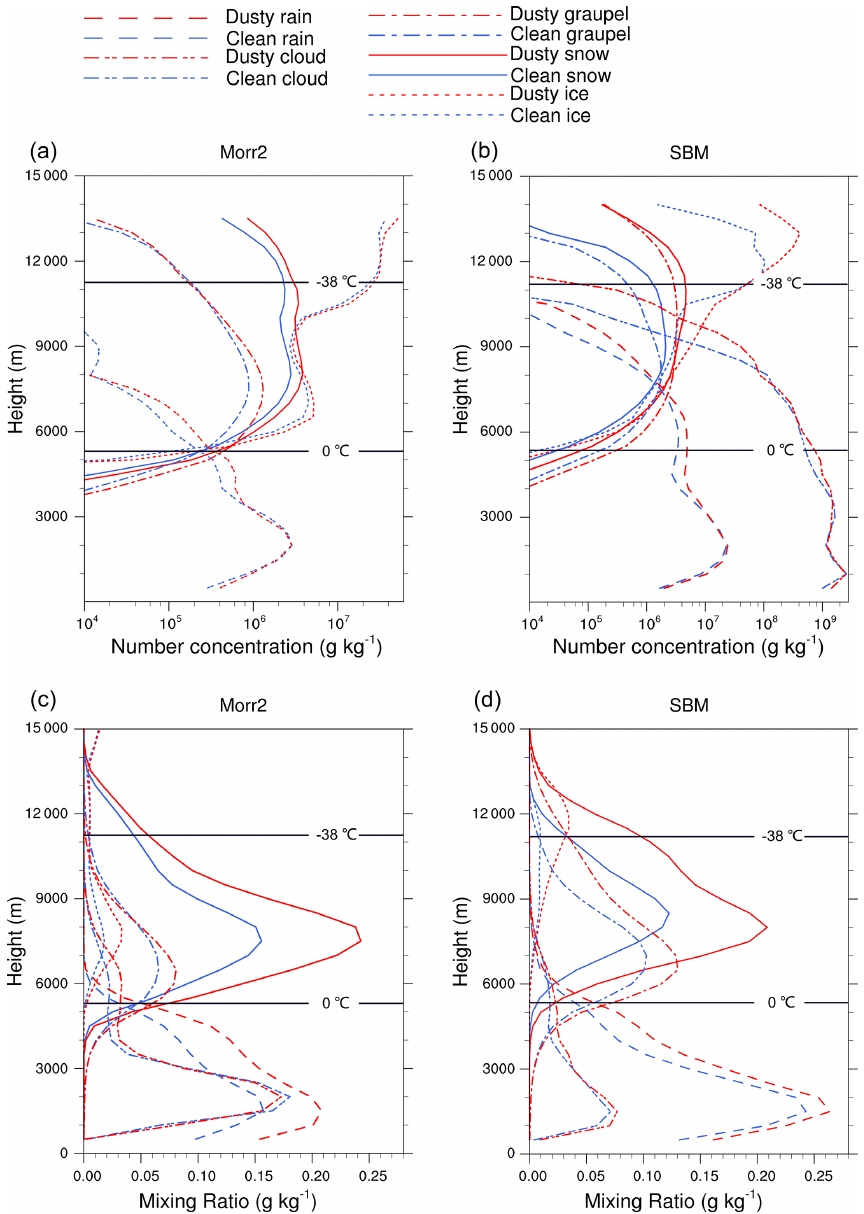
Figure 7. Vertical profiles of number concentrations of cloud hydrometers averaged among precipitation grids in the High-Pcp area from 11:00–15:00LT simulated by (a) Morr2-Clean (blue lines) and Dusty (red lines), and (b) SBM-Clean (blue lines) and Dusty (red lines) runs. Similar time–space-averaged vertical profiles of hydrometeor mass mixing ratios by (c) Morr2-Clean (blue lines) and Dusty (red lines) and (d) SBM-Clean (blue lines) and Dusty (red